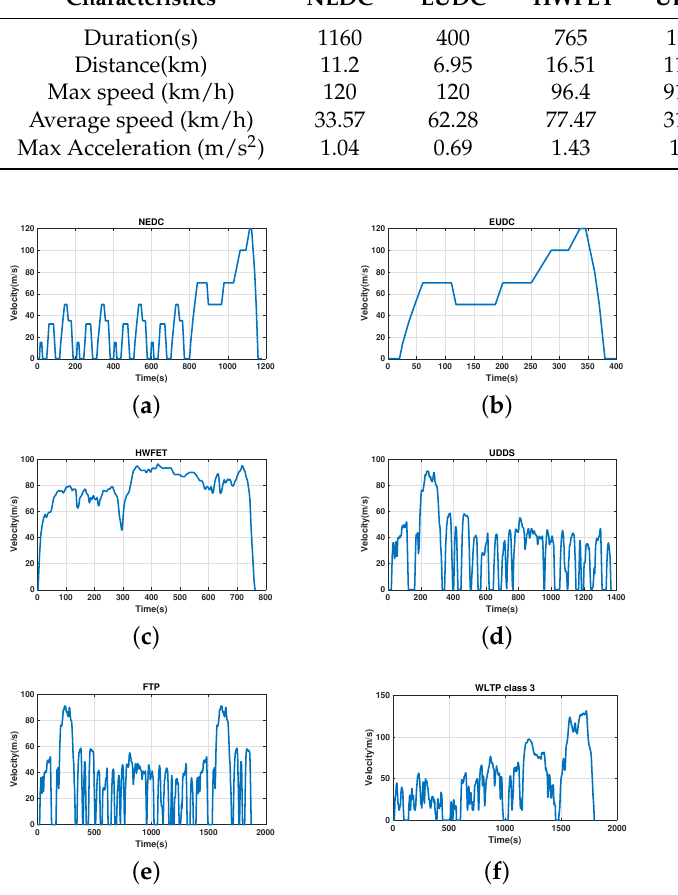
Figure 1. Velocity time profile of some standard driving cycles. ( a ) NEDC; ( b ) UDDS; ( c ) HWFET; ( d ) UDDS; ( e ) FTP; ( f ) WLTP Class